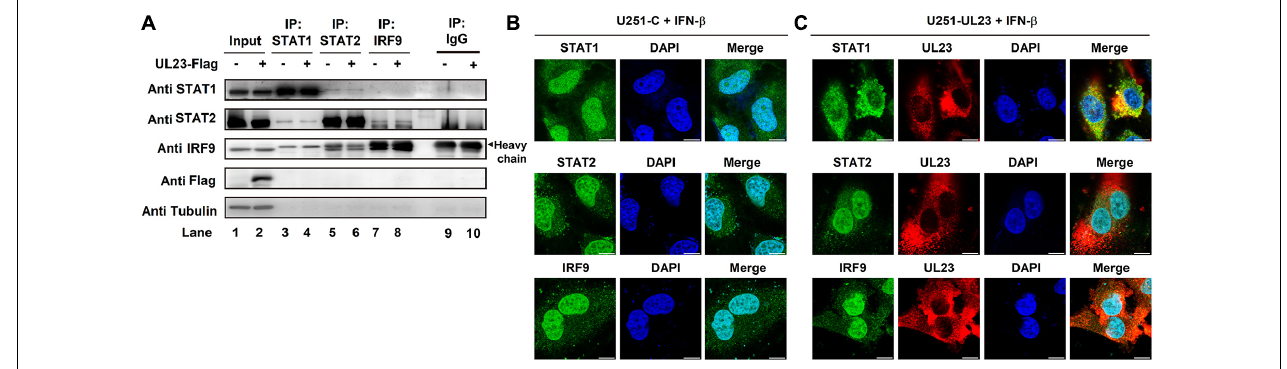
FIGURE 5 | UL23 disrupts the nuclear localization of STAT1 in response to type I IFN. (A) Empty vector or Flag-UL23 expression plasmid was transfected into HEK-293T cells. After transfection for 46 h, the lysed cells were subjected to immunoprecipitation by using anti-IRF9, anti-STAT1, and anti-STAT2 antibodies, separately, and then to immunoblotting by using specific antibodies; 100 U/ml IFN- β was then used to treat (B) U251-C cells and (C) U251–UL23 cells for a period of 0.5 h. After fixation, antibodies were used to stain the cells, as indicated. The images of UL23 (red), STAT1 (green), STAT2 (green), and IRF9 (green) were merged with DAPI-stained nuclei (blue) to generate composite images. Scale bars, 10 µ